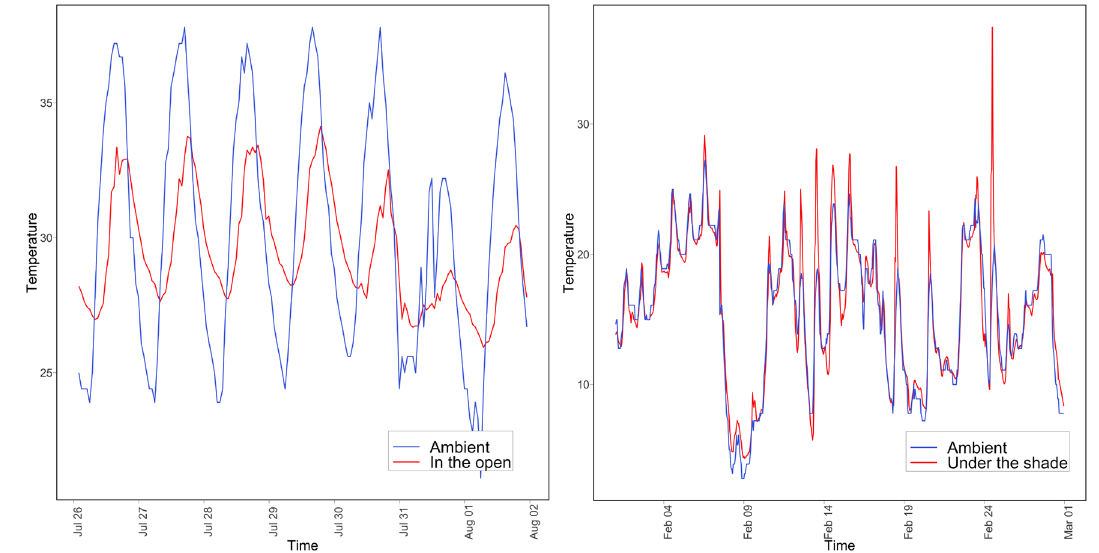
Figure 3. Ambient versus microclimatic temperatures (left) in open (right) tree coverage.